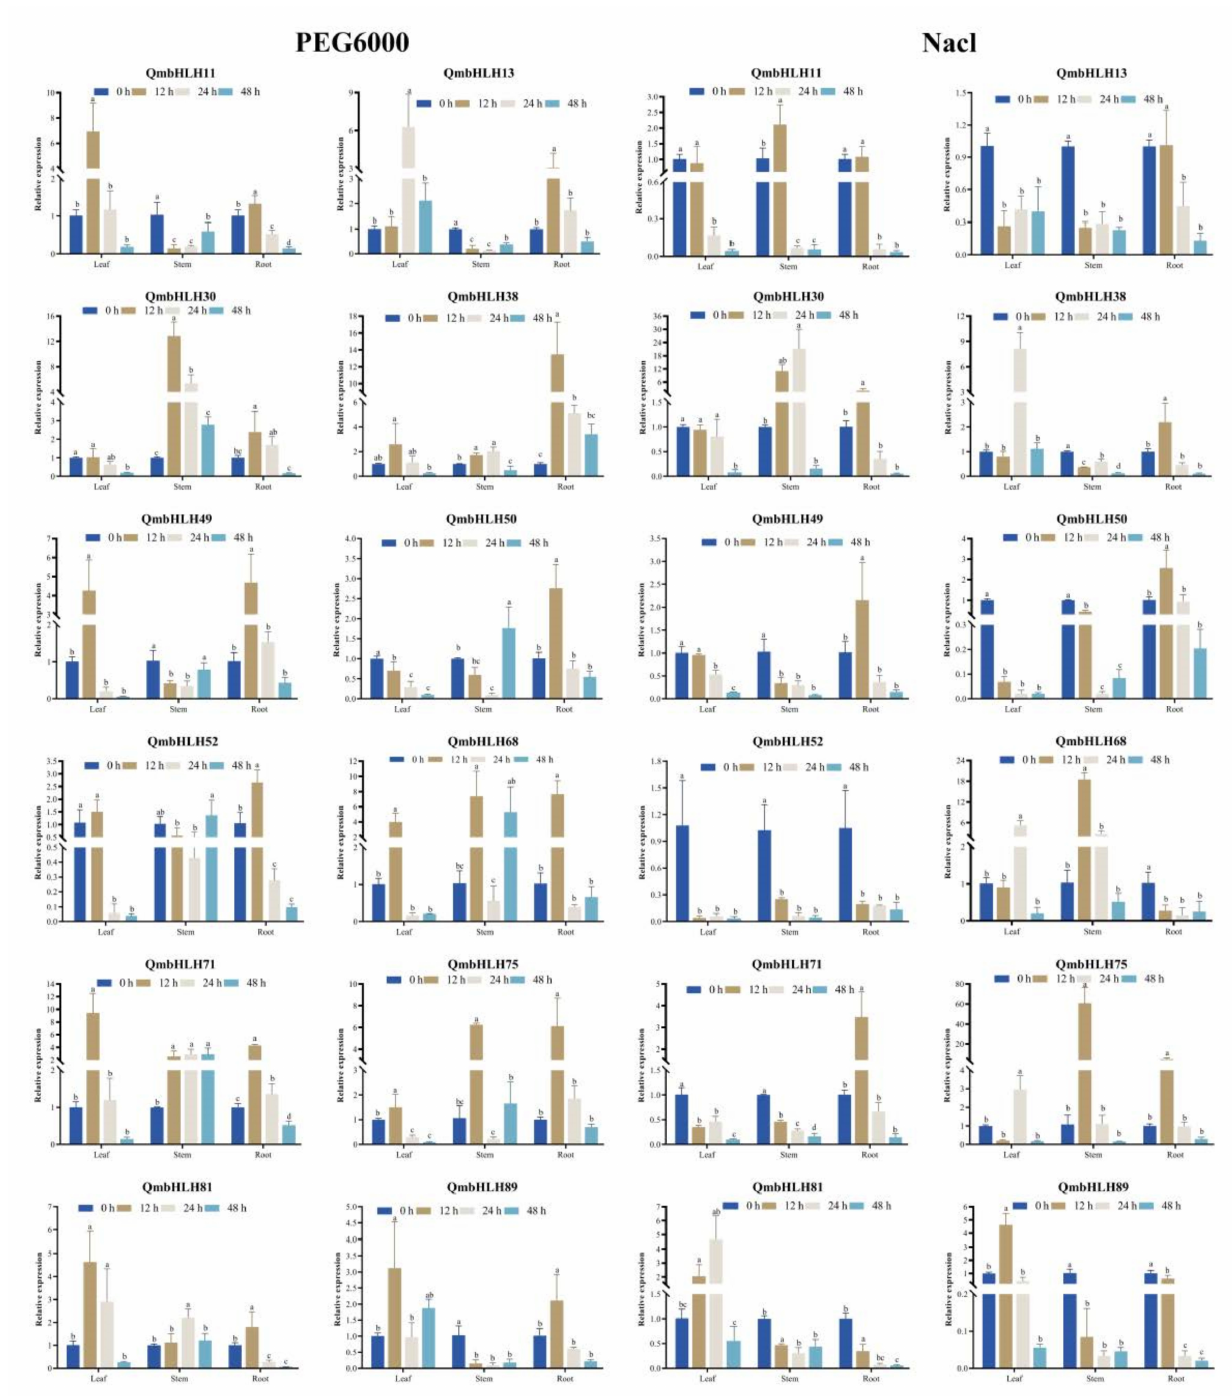
Figure 8. Expression patterns of 12 QmbHLH genes in leaf, stem, and root tissues under PEG6000 and NaCl treatments via qRT-PCR. Different letters in each treatment indicate significant differences in QmbHLH gene expression ( p < 0.05, Duncan’s